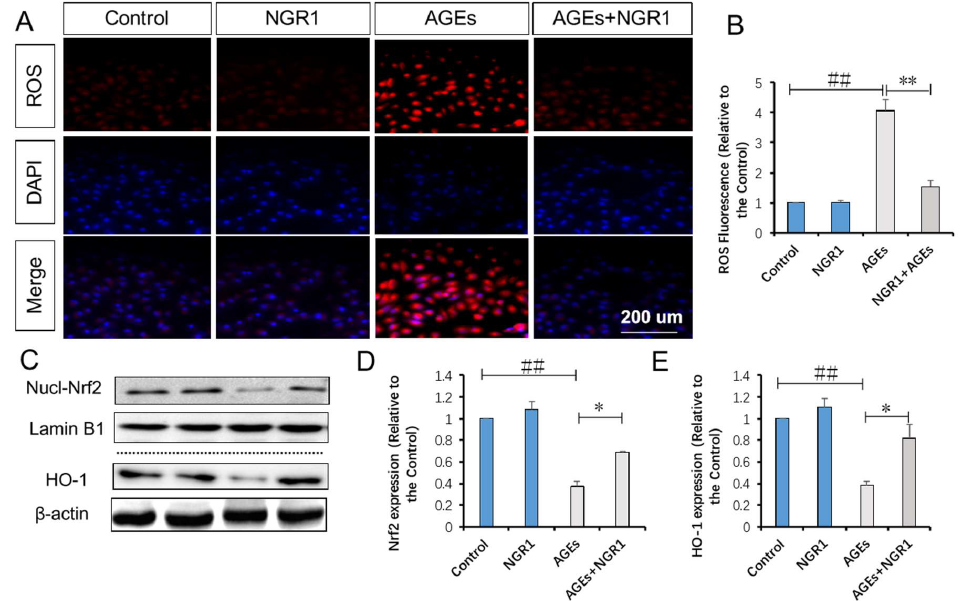
Figure 7. NGR1 inhibited intracellular reactive oxygen species (ROS) production in HK-2 cells exposed to AGEs via upregulation of Nrf2-mediated HO-1 expression. ( A ) Fluorescence images and ( B ) the bar diagram show ROS levels in HK-2 cells; the fluorescence intensity of ROS was